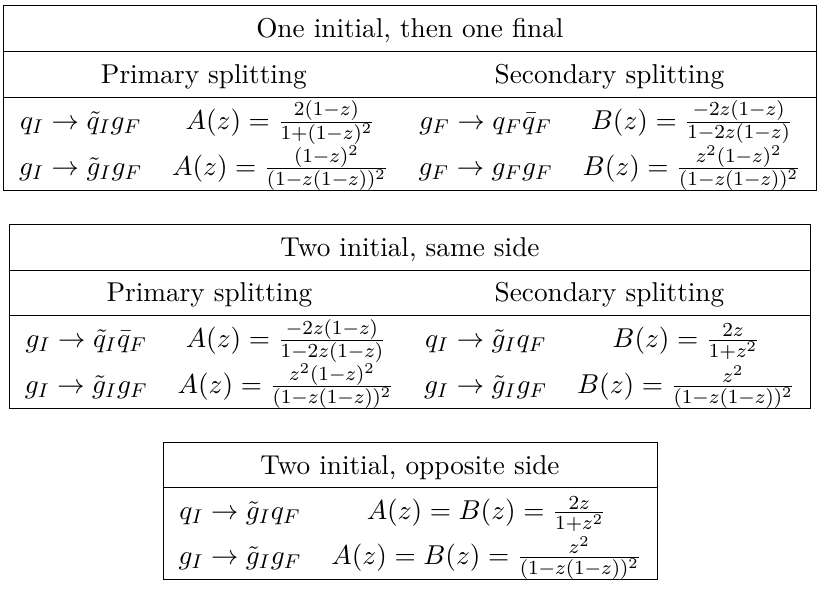
Table 2. The coefficients A ( z ) and B ( z ) in eq. (6.6) for all possible sequences that involve at least one initial-state branching and non-zero spin correlations. The separate cases correspond with a final-state secondary branching (top), a same-side initial-state secondary branching (middle), and an opposite-side initial-state secondary branching (bottom). These results complement the corresponding final-state ones given in table 2 of ref.